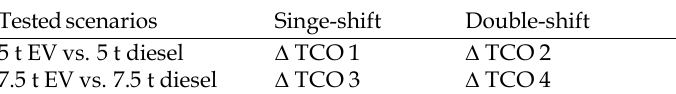
Table 2. Tested TCO calculations Tested scenarios